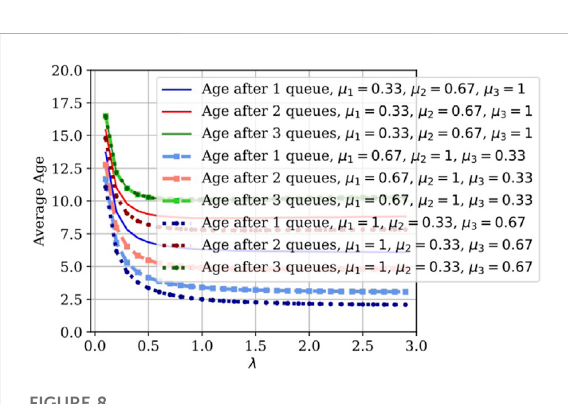
FIGURE 6 Averageagevs. λ , μ =1,queuecapacityofoneafterthreeand four queues (vs. approximation).